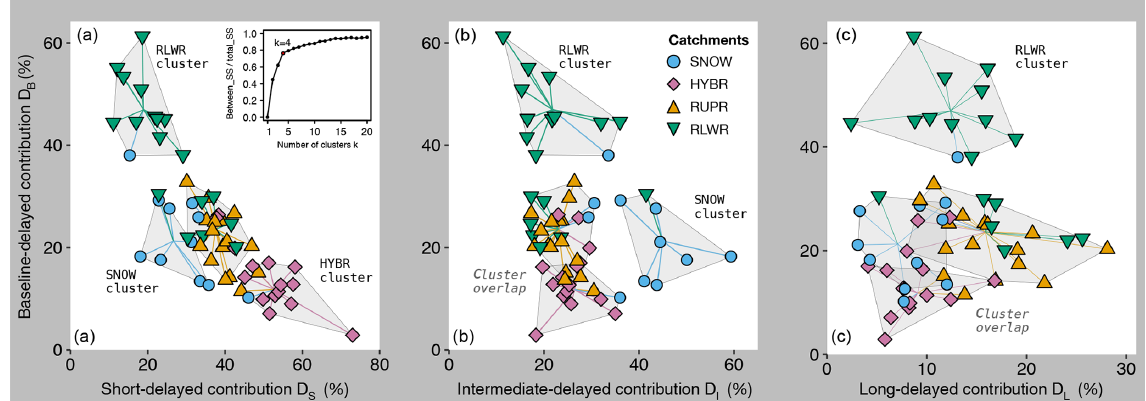
Figure 9. Relationship between short (a) , intermediate (b) and long-delayed (c) contributions and baseline-delayed contributions (each time on the y axis). Each point represents one catchment and is coloured by its catchment group (RLWR, RUPR, HYBR or SNOW). Each grey polygon is the envelope of one cluster, and the lines within the polygon are pointing to the cluster centre. The inset in (a) shows the ratio of the between-cluster sum of squares (between_SS) and total sum of squares (total_SS), i.e. the ratio of explained